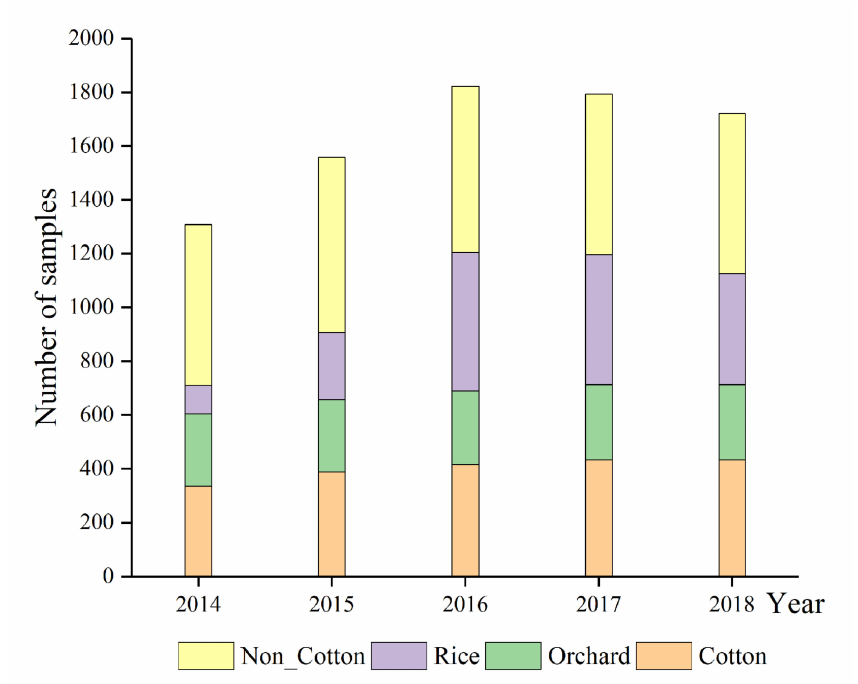
Figure 3. Number of samples for each annual year, in which 30% are training samples and 70% are verification